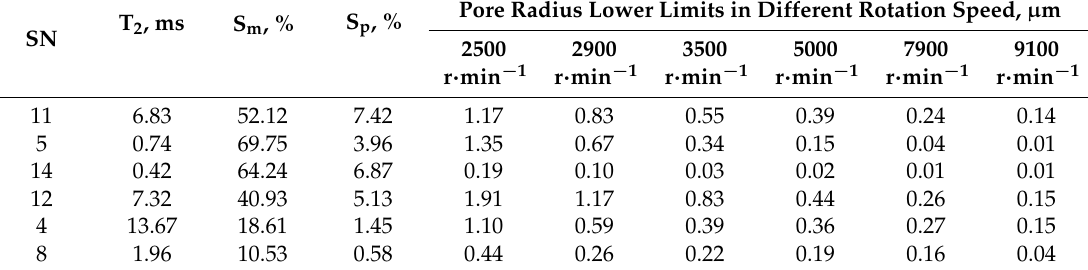
Table 4. The parameters for movable fluid parameters from NMR.